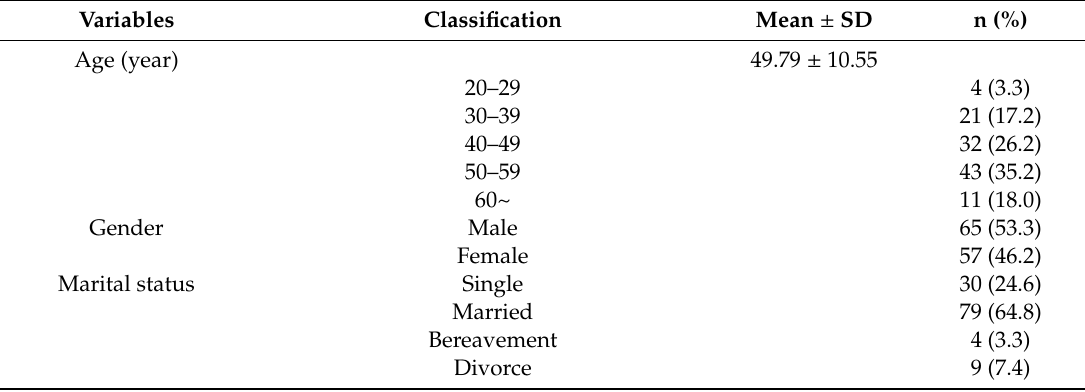
Table 1. Demographic characteristics of kidney transplant recipients (n =